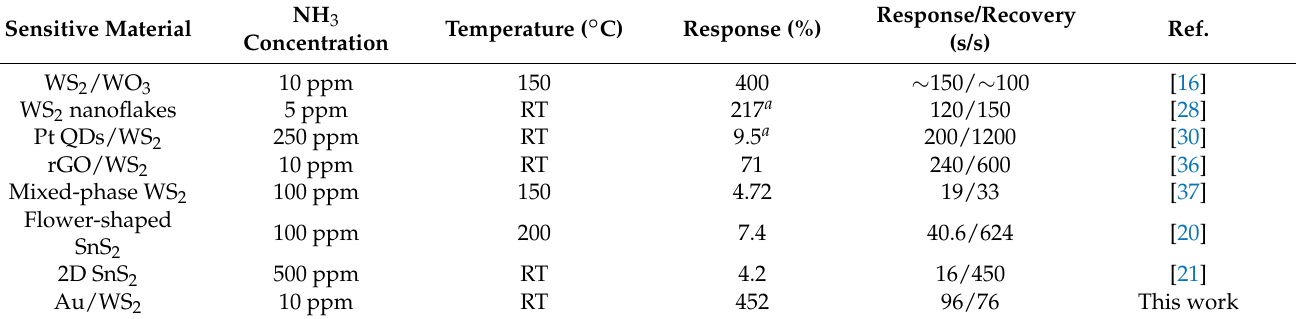
Figure 6. ( a ) Pure WS 2 and Au/WS 2 gas sensors response to 10 ppm NH 3 at room temperature; ( b ) the as-fabricated gas sensors response and recovery times to 10 ppm NH 3 . Table 1. A comparison of the performance of NH 3 sensors based on WS 2 and TMDs